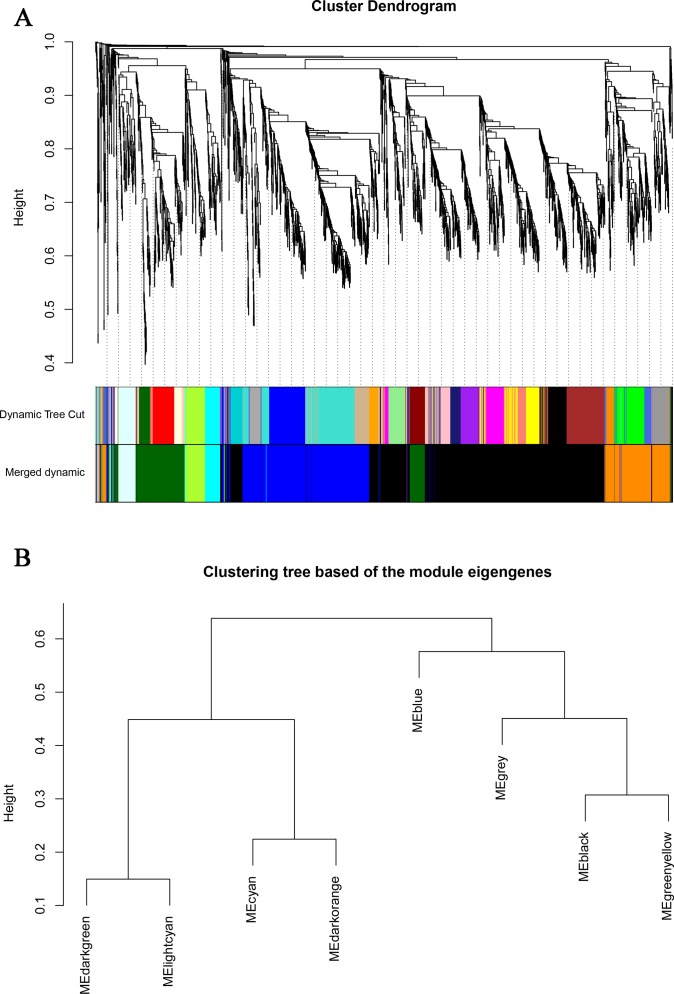
Visualization of module detection and clustering.A) Hierarchical cluster tree (average linkage, dissTOM) of the 2,510 genes. The color bands provide a simple visual comparison of module assignments (branch cuttings) based on the dynamic hybrid branch cutting method. B) Clustering of modules based on eigengenes.